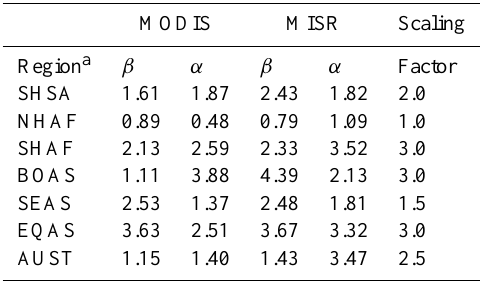
Table A2. Values of the scaling factors α and β for the seven GFED regions with annual fire emissions of greater than 100TgCyr − 1 . The values of α for MODIS and MISR data were averaged and rounded to the nearest multiple of 0.5 to give the scaling factor ap- plied to the fire emissions in the forward model